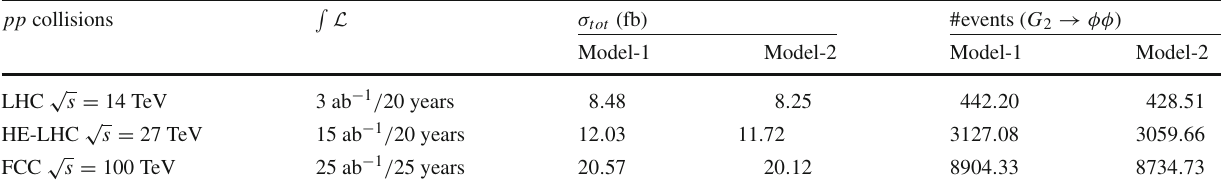
Table 1 Cross sections and associated number of events in the ten- sor glueball decay mode G 2 → φφ for the tensor glueball produc- tion in pp collisions. The integrated luminosities selection come from